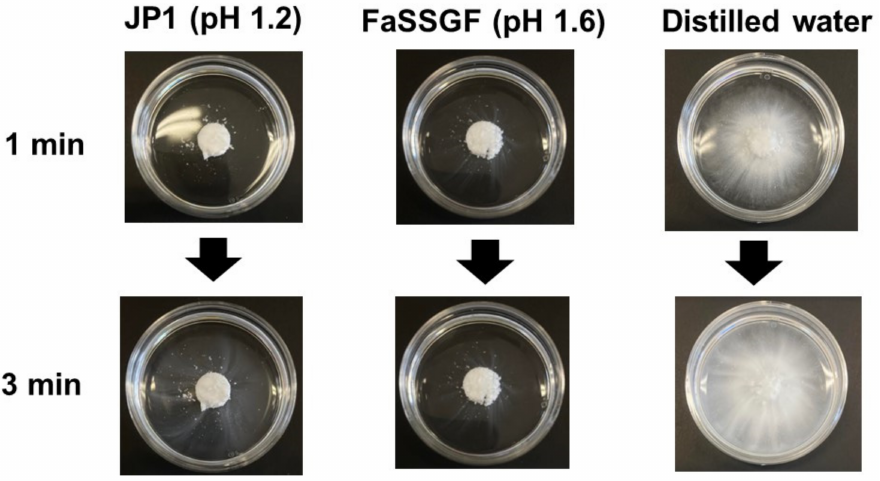
Figure 9. Disintegration of Flivas ® OD tablets after addition of JP1, FaSSGF, or distilled water onto the